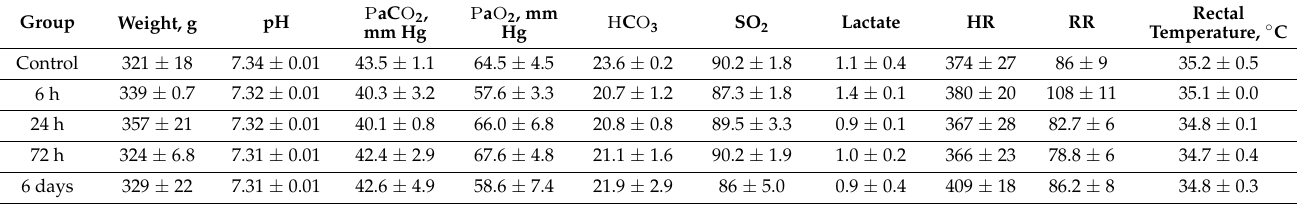
Table 1. Physiological parameters of the anesthetized rats (prior to MCAO).